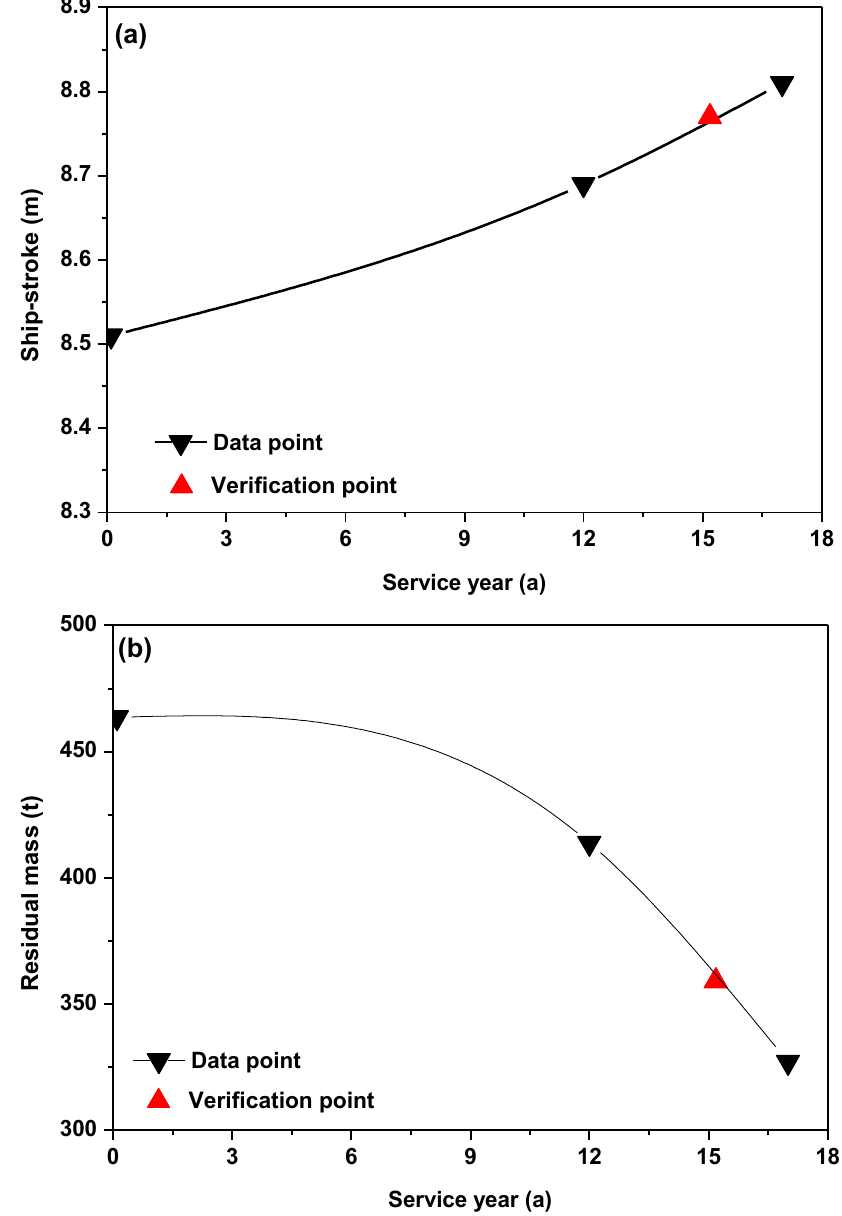
Figure 9. Prediction and verification of key impact factors ( a ) ship stroke prediction and ( b ) residual mass prediction considering corrosion effects.